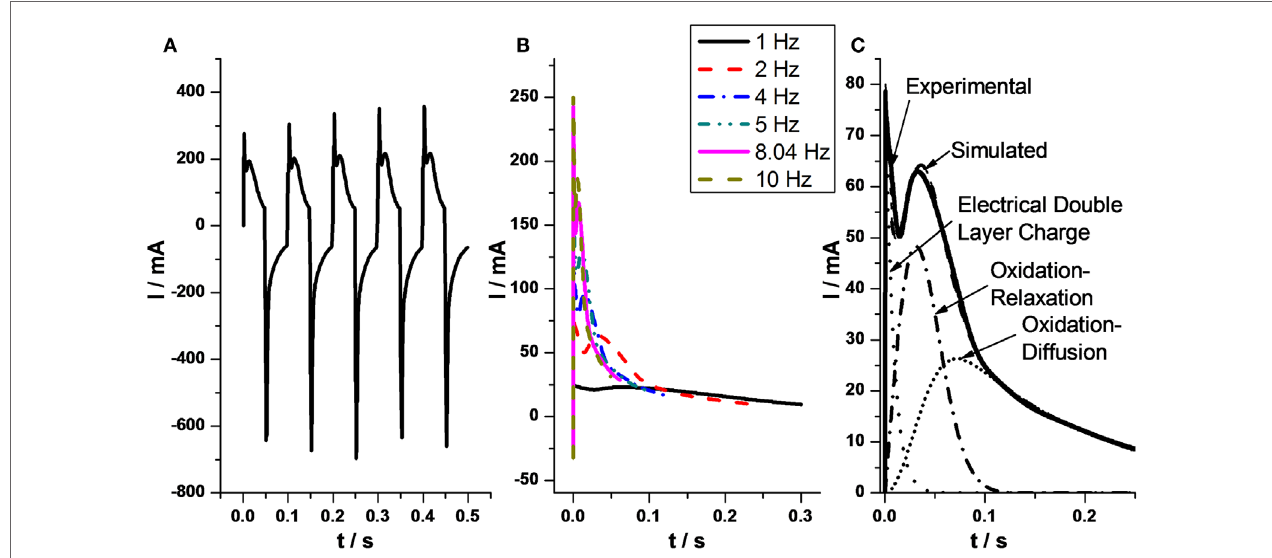
FiGURe 3 | (A) Five consecutive anodic and cathodic chronoamperometric responses obtained from a SG–SWNT triple layer actuator submitted to ± 2 V square potential waves at 10 Hz. (B) Anodic chronoamperometric responses from SG–SWNT actuator under different frequencies, from 1 to 10 Hz, of the square potential waves. (C) Experimental anodic chronoamperometric responses from SG–SWNT when the actuator was submitted to ± 2 V square potential waves at a frequency of 2 Hz. Dotted line: capacitive charge of the electrical double layer (EDL). Dash-dotted line: oxidation under relaxation–nucleation kinetic control. Short dotted line: oxidation under diffusion kinetic control of the balancing counterions through the nanotube film. Dashed line: simulated responses obtained by addition of the three components. Reproduced from Gimenez et al. (2012), with permission from